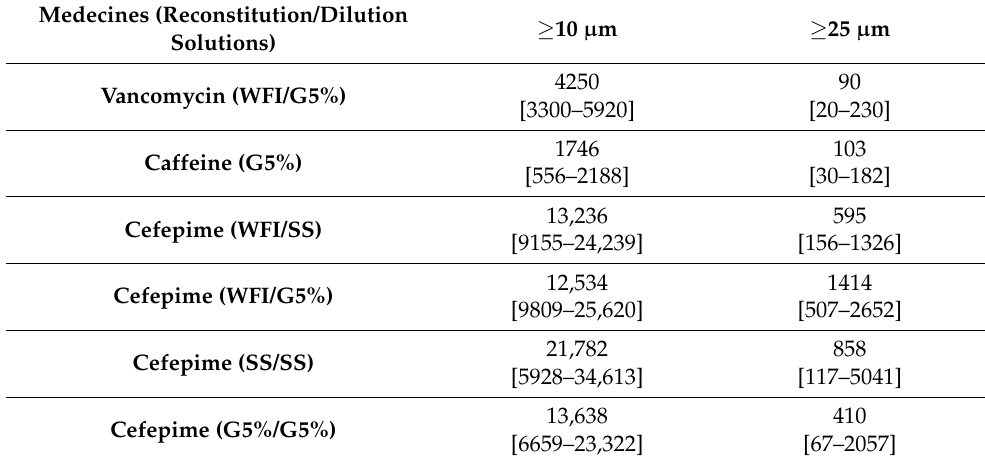
Table 3. According to the EP specifications for containers with a volume ≤ 100 mL, the vancomycin and caffeine solutions conformed but the cefepime solution did not. Table 3. Static count of particles ≥ 10 and ≥ 25 µ m with the APSS-2000. Median [min–max], n =